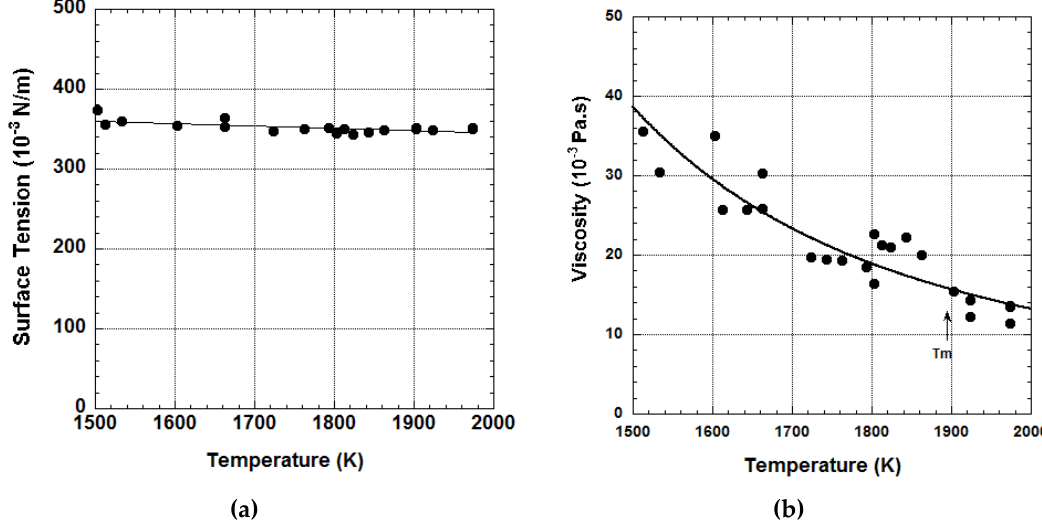
Figure 16. Measured surface tension ( a ) and viscosity ( b ) of molten BaTiO 3 versus temperature